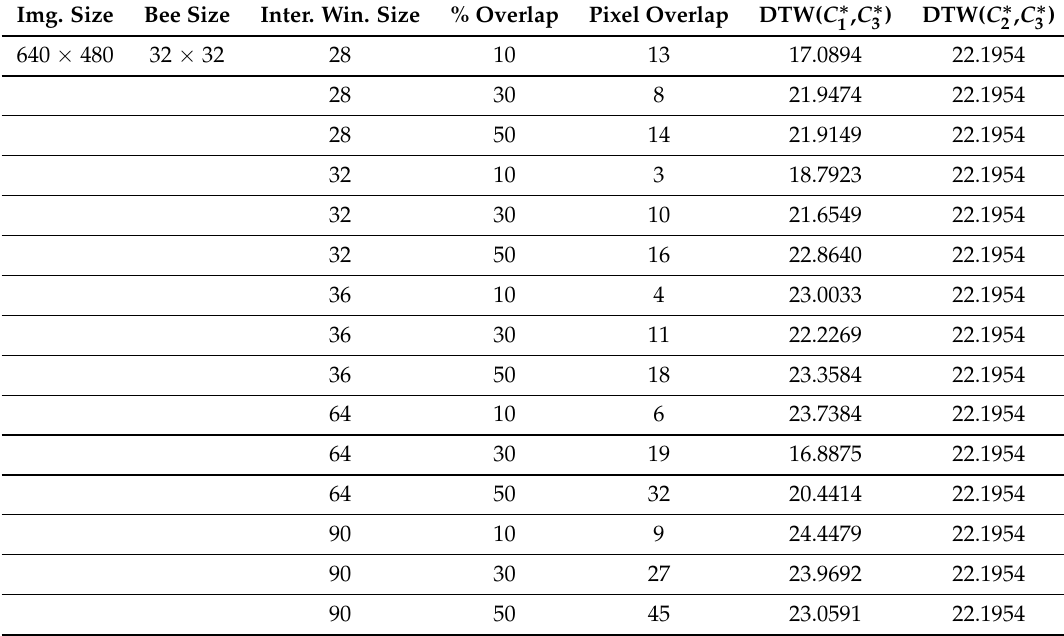
Table A5. DTW values for MT _ Vid . mp 4 with image size of 640 × 480; C ∗ and C ∗ is Human Count (ground truth). 3